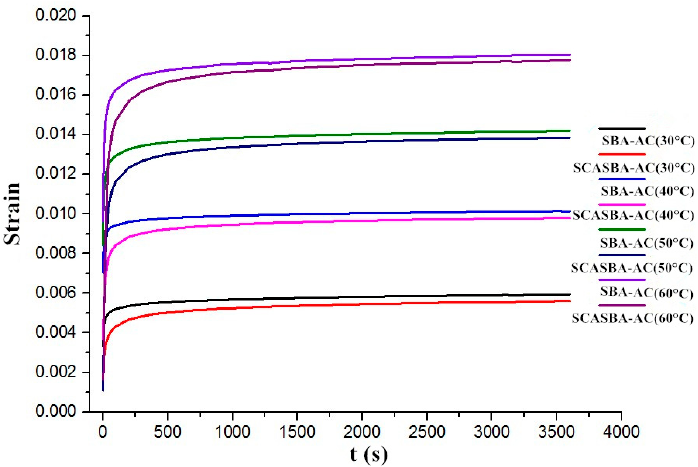
Figure 19. Static creep strain curves of SBA-AC and SCASBA-AC at different temperatures.